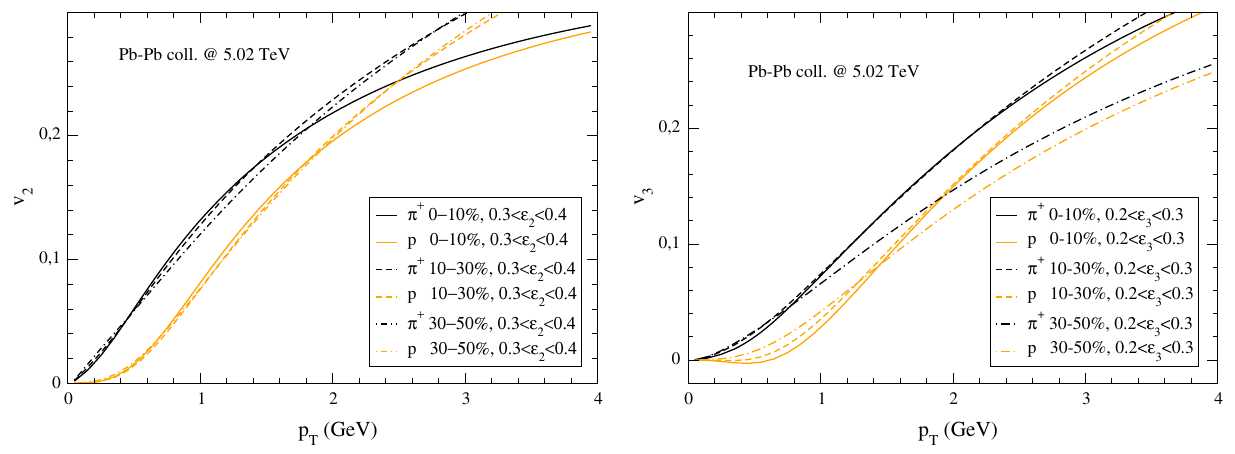
Fig. 8 The initial entropy-density for Pb–Pb collisions at classes